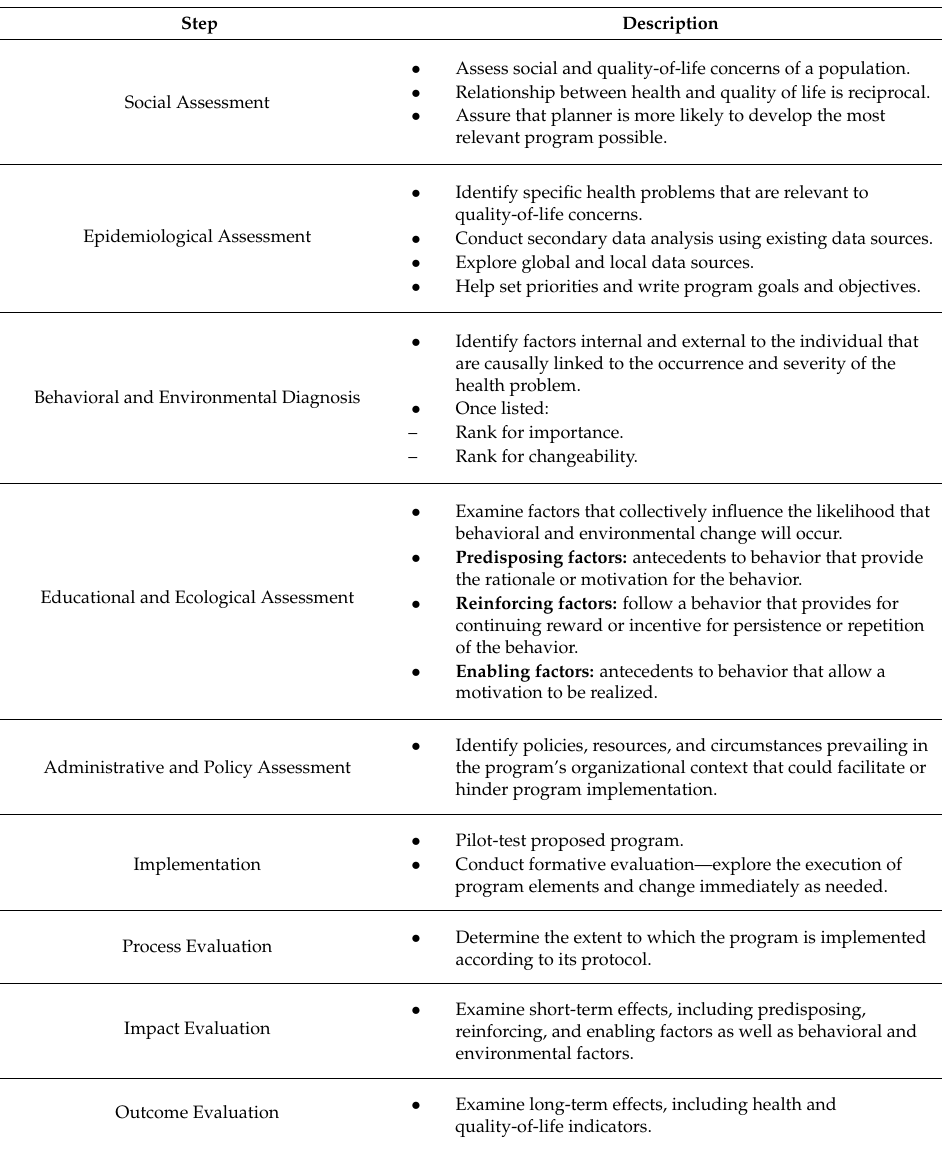
Table 5. Steps in the predisposing, reinforcing, and enabling constructs in educational/environmental diagnosis and evaluation (PRECEDE) policy, regulatory, and organizational constructs in educational and environmental development (PROCEED) model of health program planning